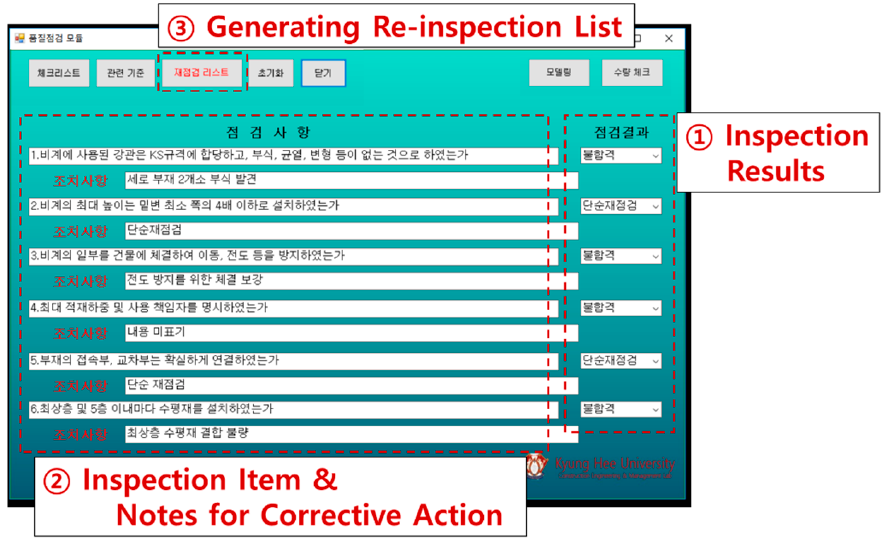
Figure 14. Quality inspection module—quality inspection result input.